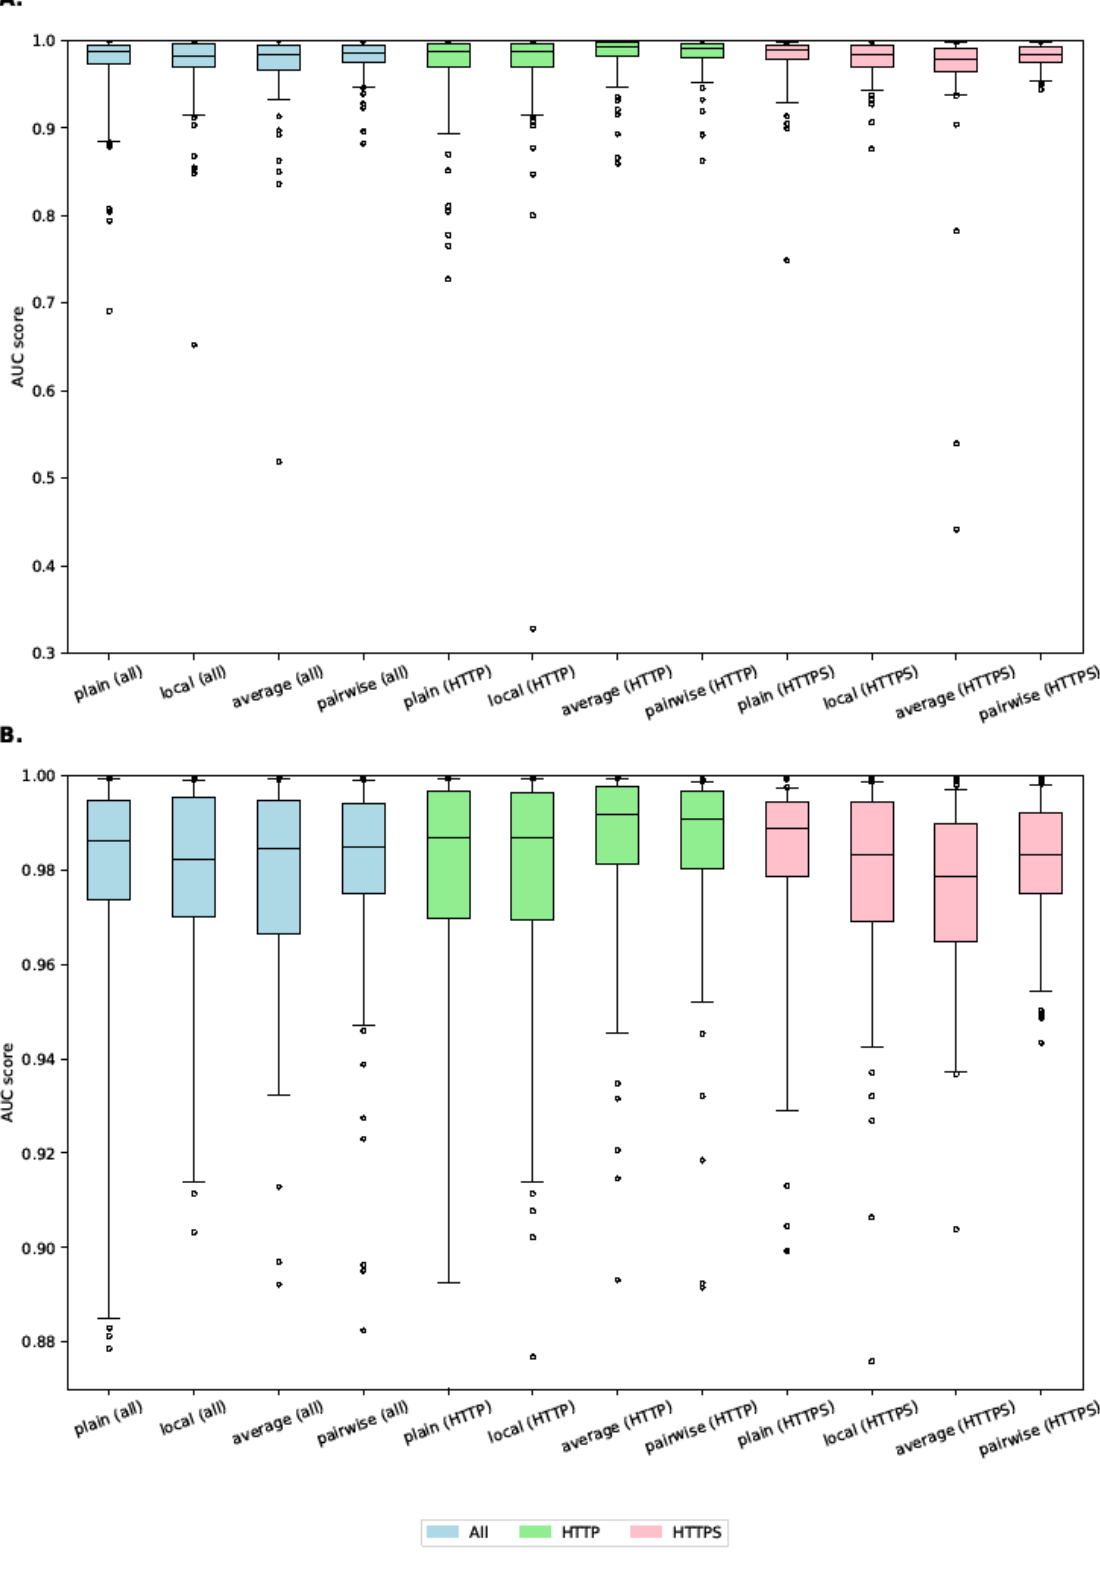
Figure 8. Comparison of AUCs ( A ) per-flow anomaly score ( B ) all pairwise algorithm.